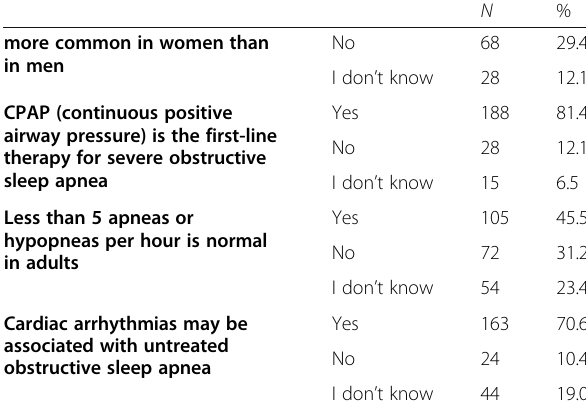
Table 2 Obstructive sleep apnea knowledge among all studied N